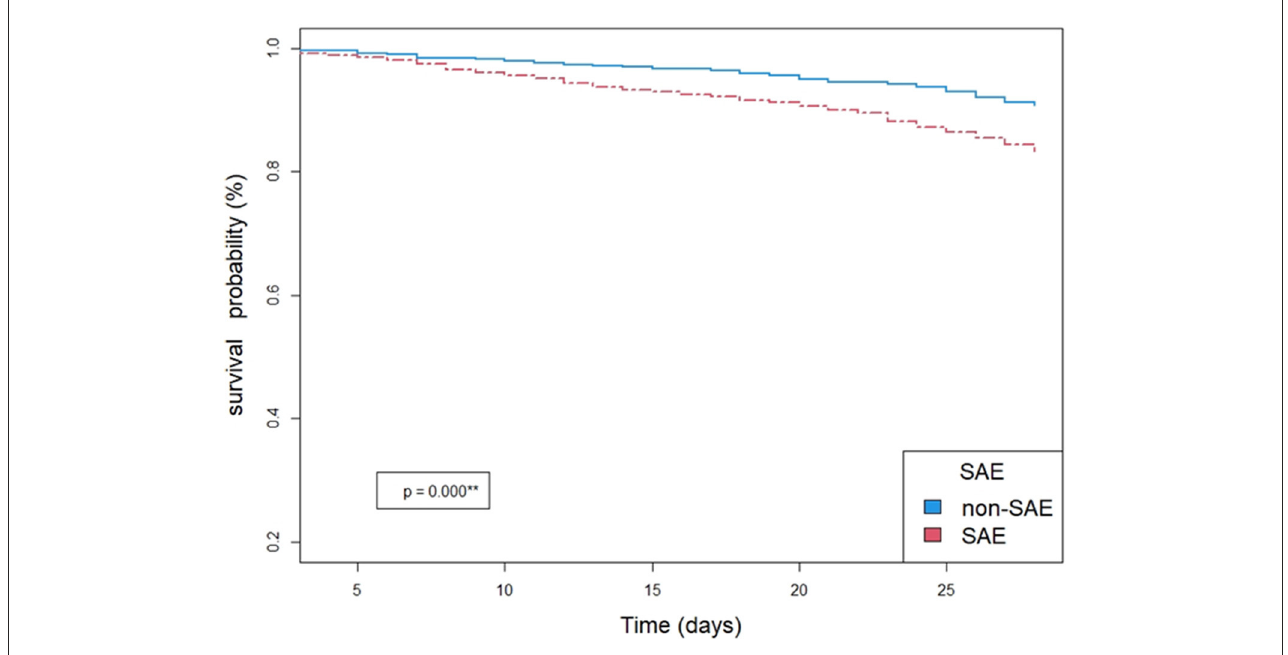
FIGURE2 Kaplan-meier survival analysis between groups of SAE and non-SAE.